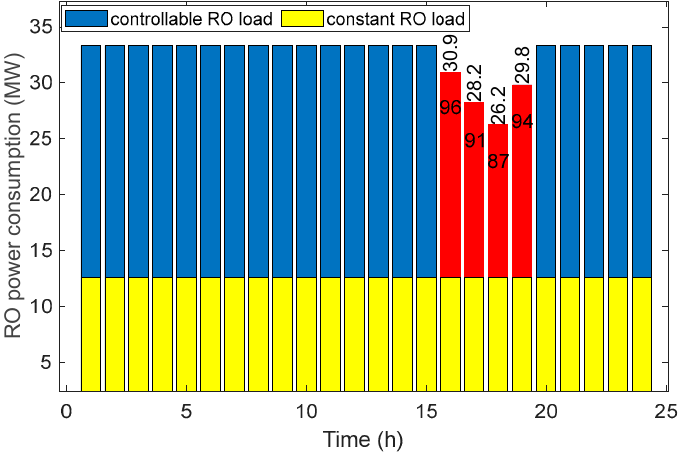
Figure 7. The hourly RO power consumption under VRRC, the number above the bars are the power consumption in MW and that inside the bars are the percent value of f ratio at each hour.